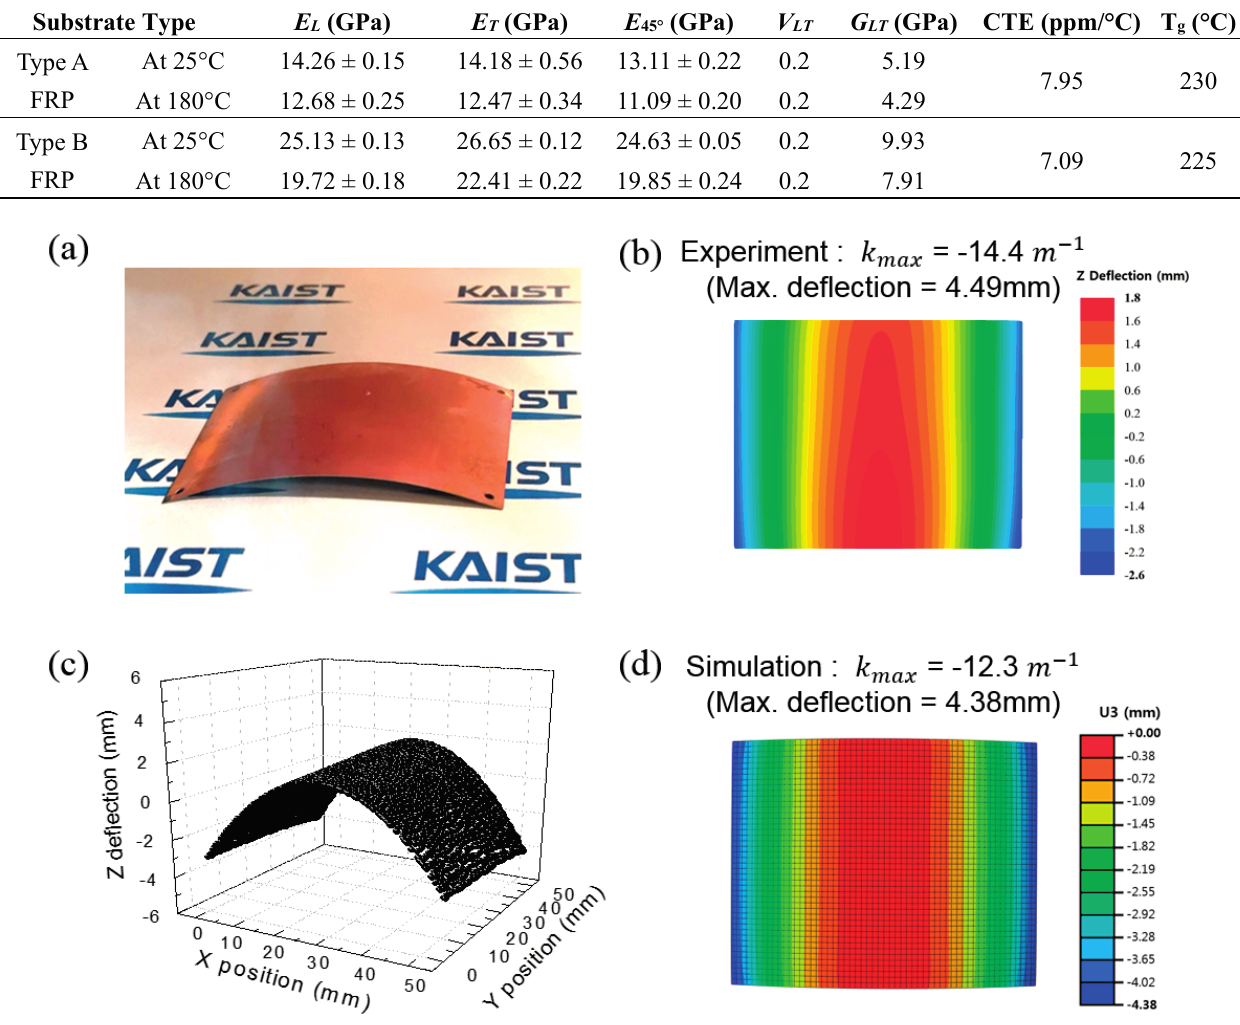
Figure 5. Type A FRP specimen with 17 μ m Cu film at 180 °C: ( a ) specimen in the heating chamber; ( b ) contour measured by 3D scanner (top view); ( c ) 3D curve fitting done by data analysis program; and ( d ) the simulation result (top